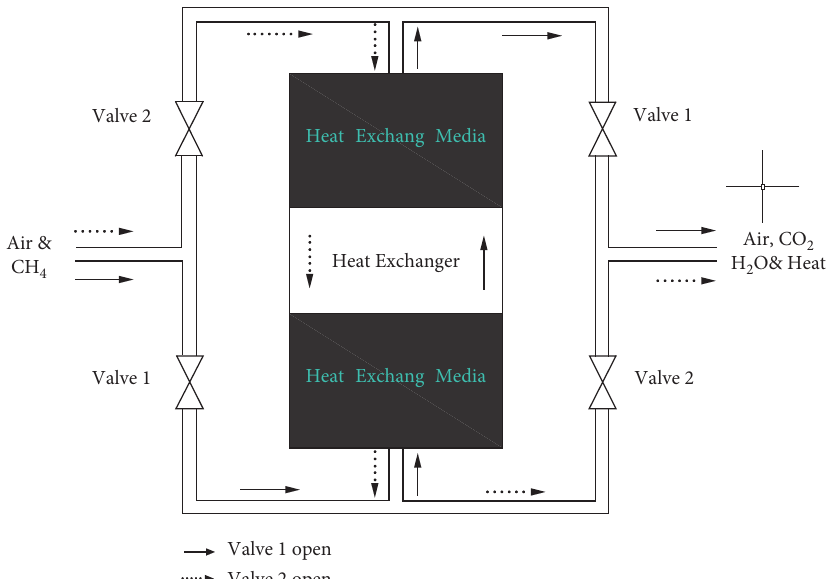
Figure 1: Schematic diagram of the thermal countercurrent oxidation